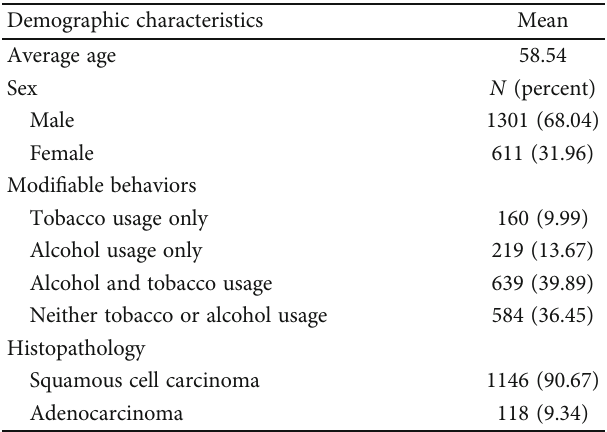
Table 2: Demographics, risk factor, and histopathology of esophageal cancer cases from Ocean Road Cancer